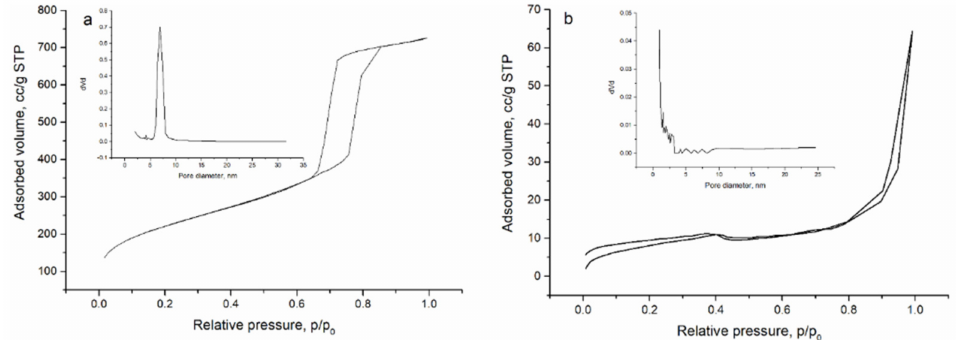
Figure 3. Nitrogen adsorption isotherms and pore size distributions for the ( a ) silica SBA-15 and ( b ) titanosilicate ETS-10.